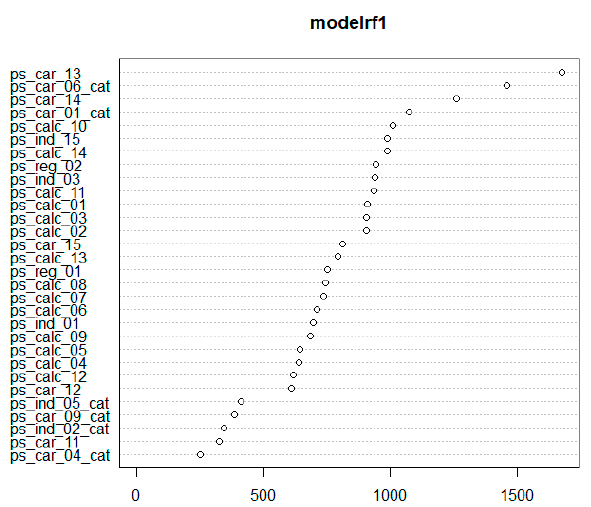
Figure 13. The rank of features by importance based on the random forest algorithm.